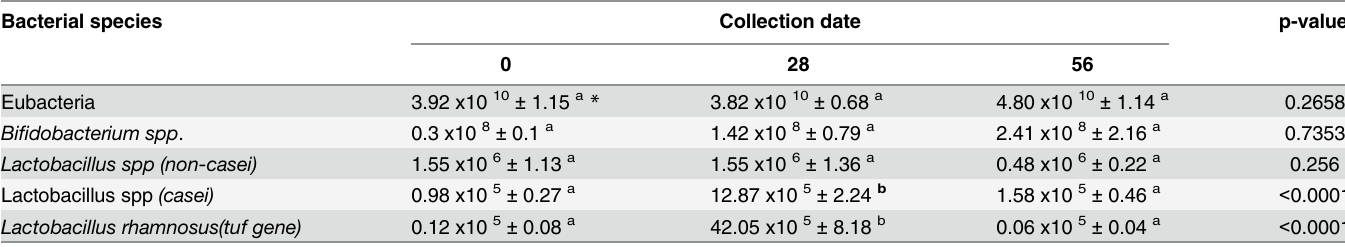
Table 1. Relative abundance of bacterial species in fecal samples after LGG treatment. Bacterial